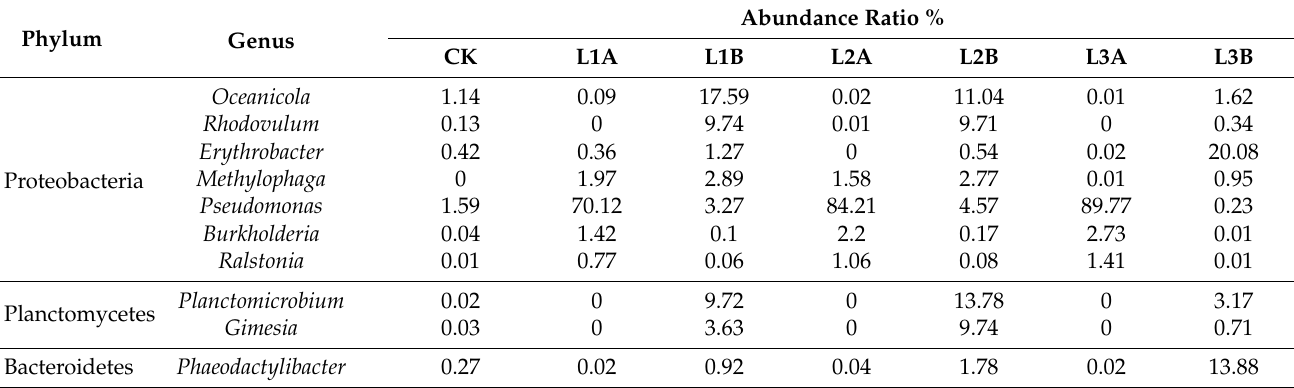
Table 3. Bacteria affected by C. vulgaris LH-1 at low crude oil concentration.